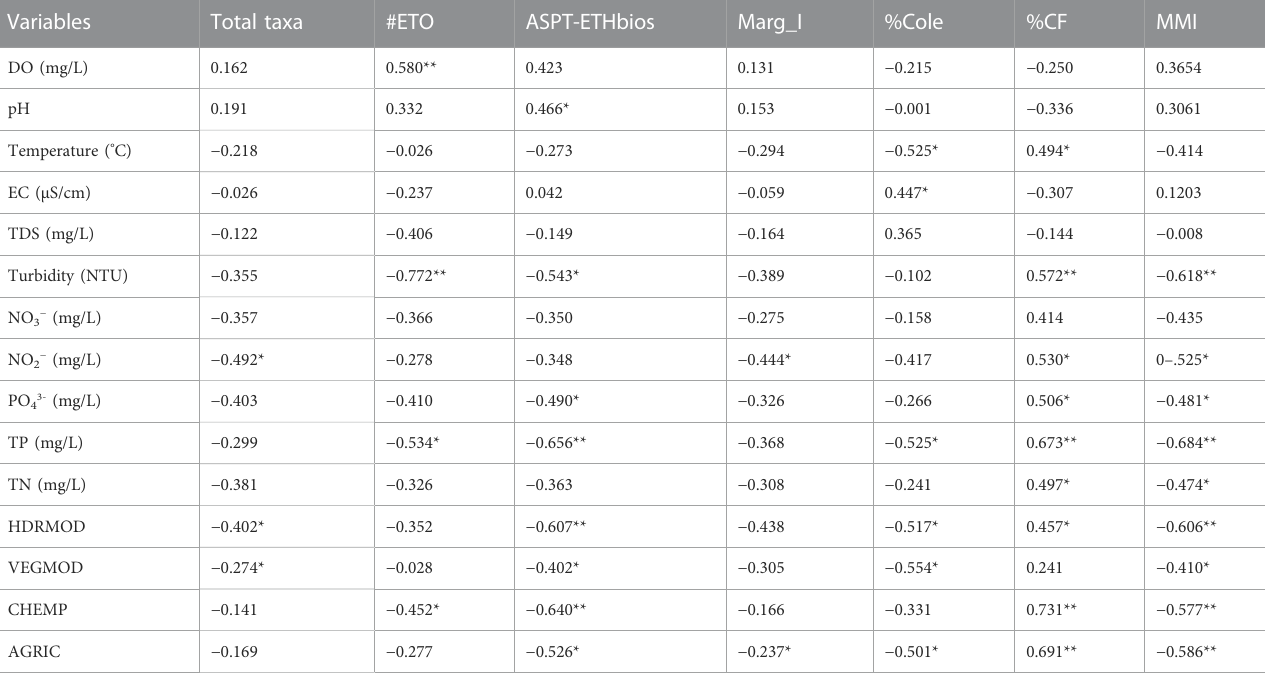
TABLE 3 Pearson correlation coef fi cients between core metrics and MMI, and environmental variables.